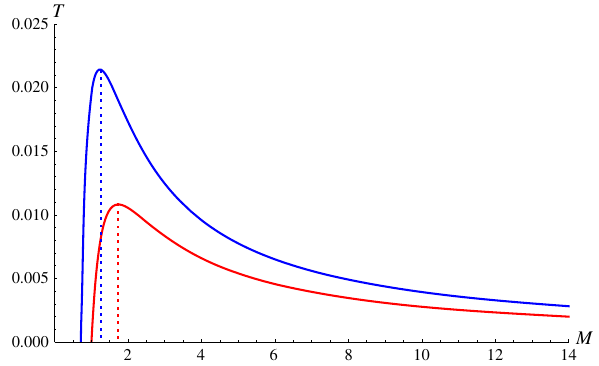
Fig. 3 Plot of the temperature versus the mass for different b . Above blue curve corresponds to β = 1 and b = 0 . 01. Below red curve corresponds to β = 1 and b = 0 . 5